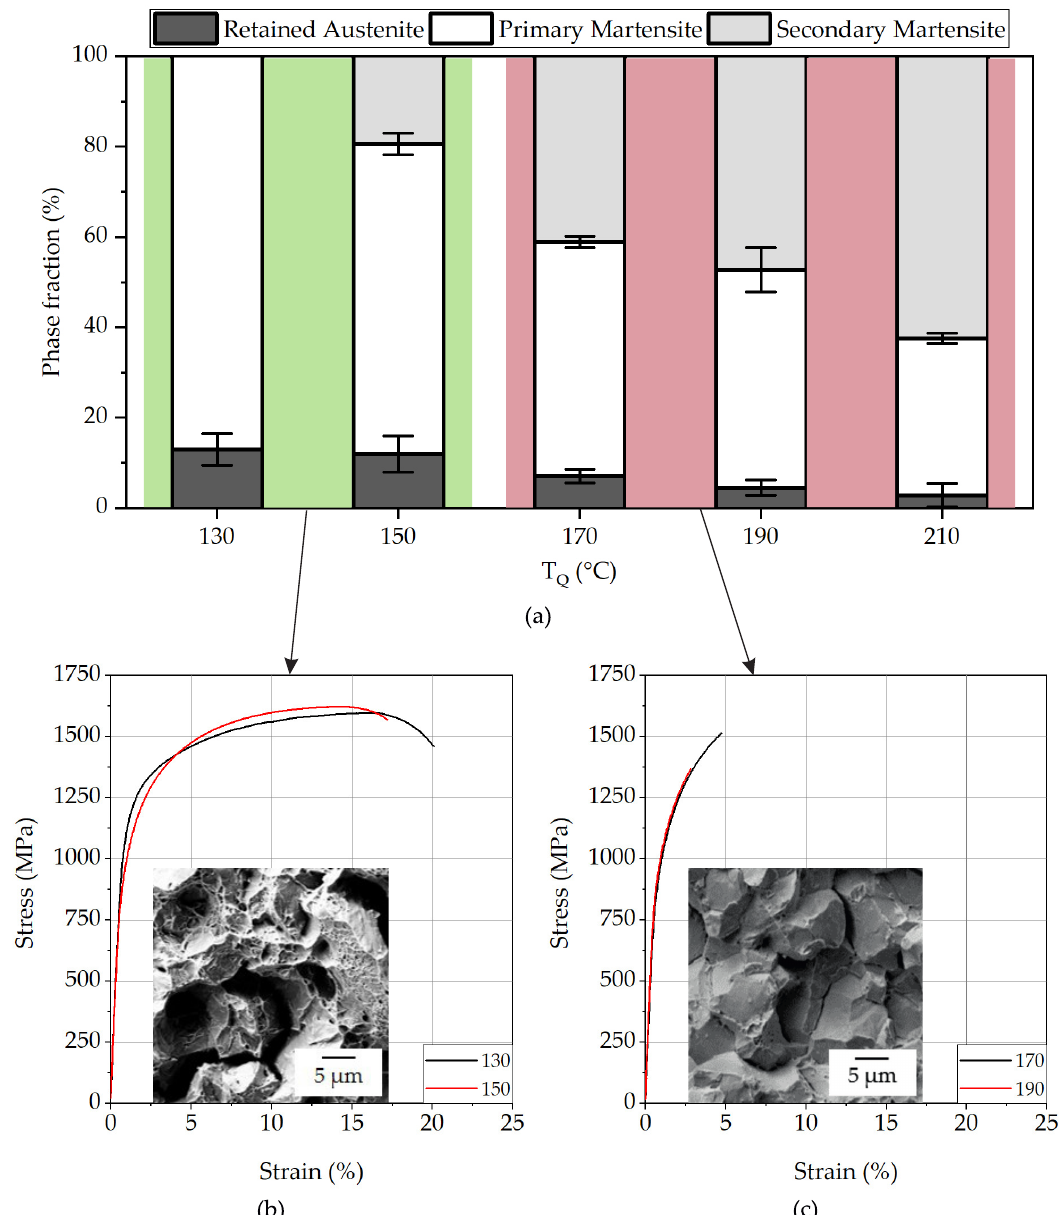
Figure 9. ( a ) Resulting final phase fractions in dependence of T Q ; ( b ) resulting stress–strain curves and representative fracture surface for investigated QP130_60 and QP150_60; and ( c ) resulting stress–strain curves and representative fracture surface for investigated QP170_60 and